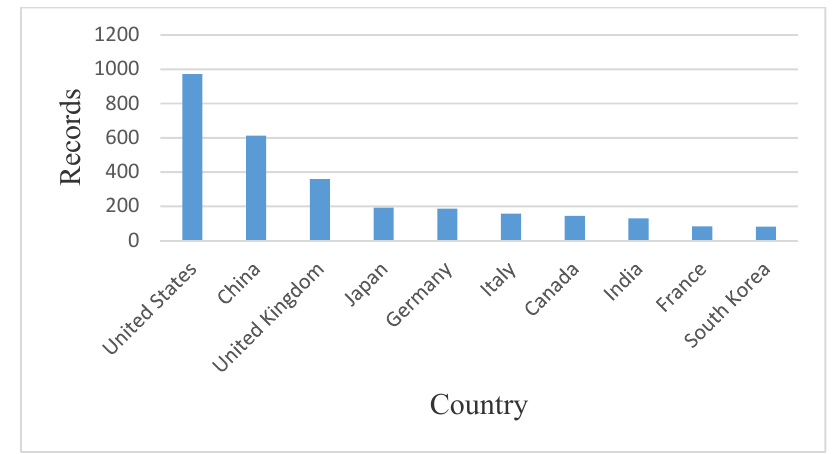
Figure 1. Publication trends in the field of gas turbine degradation.